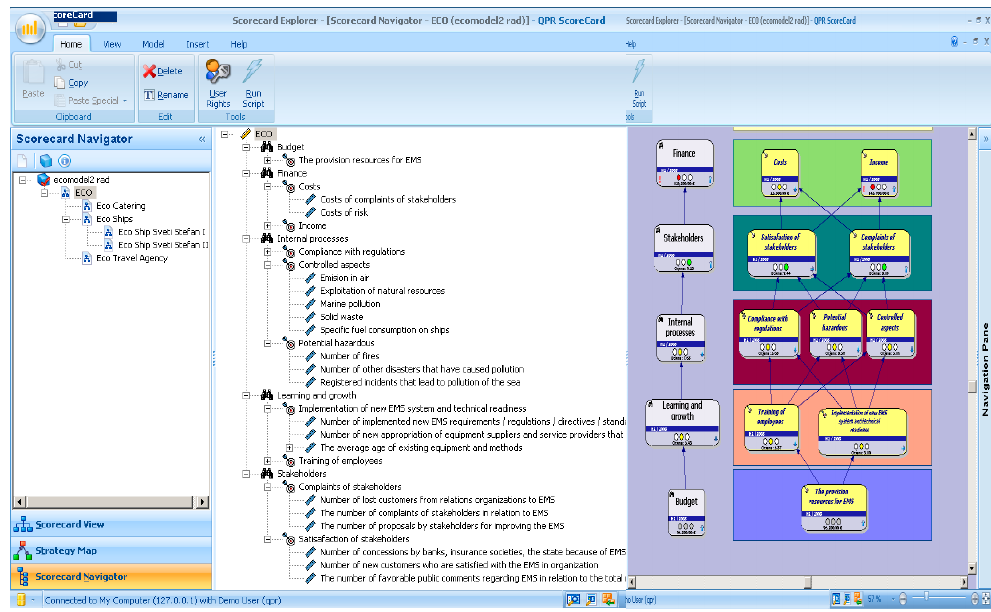
Figure 3. The ECO BSC system of the organization with a review of a strategic map (by QPR software).